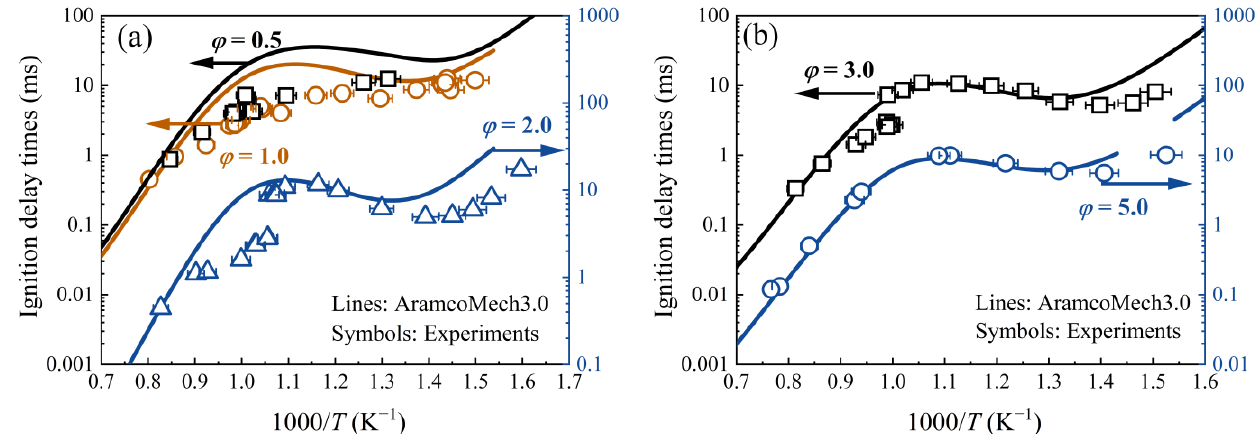
Figure 3. Measured and simulated ignition delay times of DME/‘air’ mixtures with different equiv- alence ratios at a pressure of 3.0 atm. Symbols represent experimental data from [22]. Lines represent model predictions using AramcoMech 3.0 with constant U and V assumptions. ( a ) φ = 0.5, 1.0, and 2.0. ( b ) φ = 3.0 and 5.0.